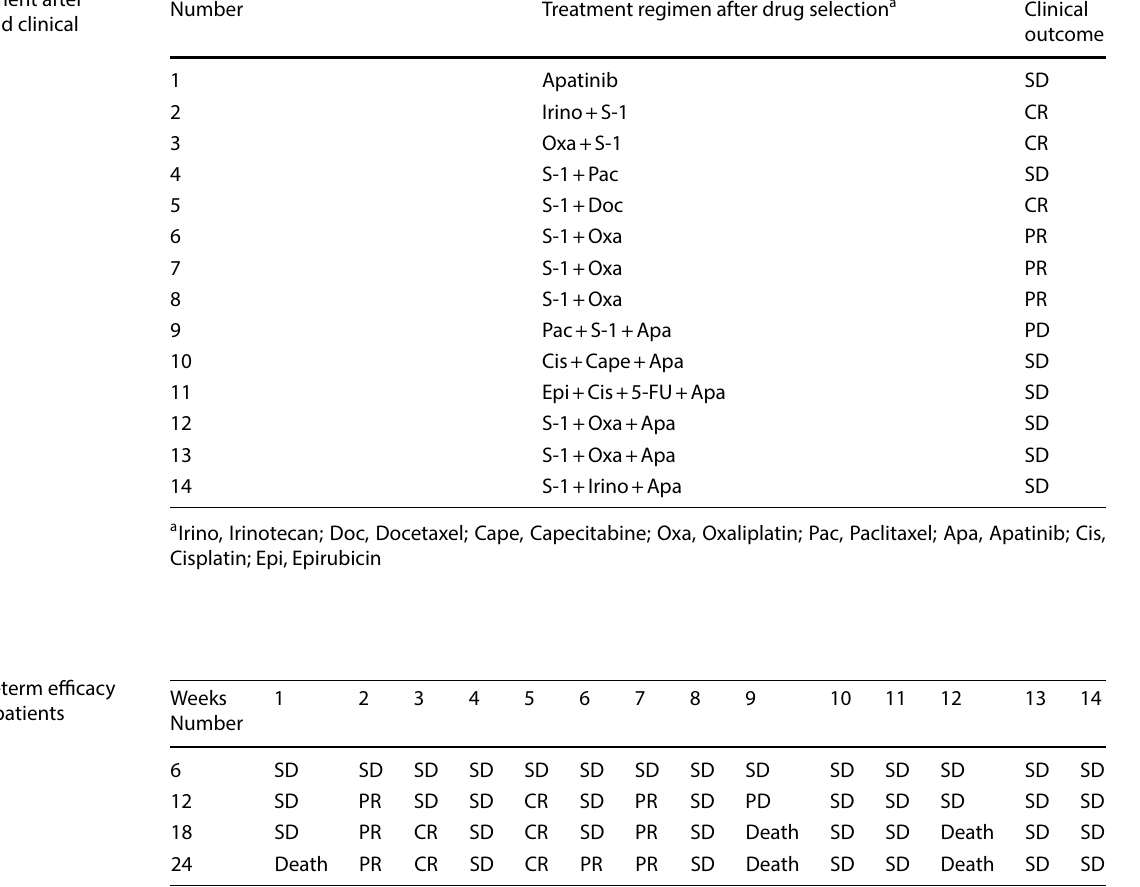
Table 4 Treatment after enrollment, and clinical response